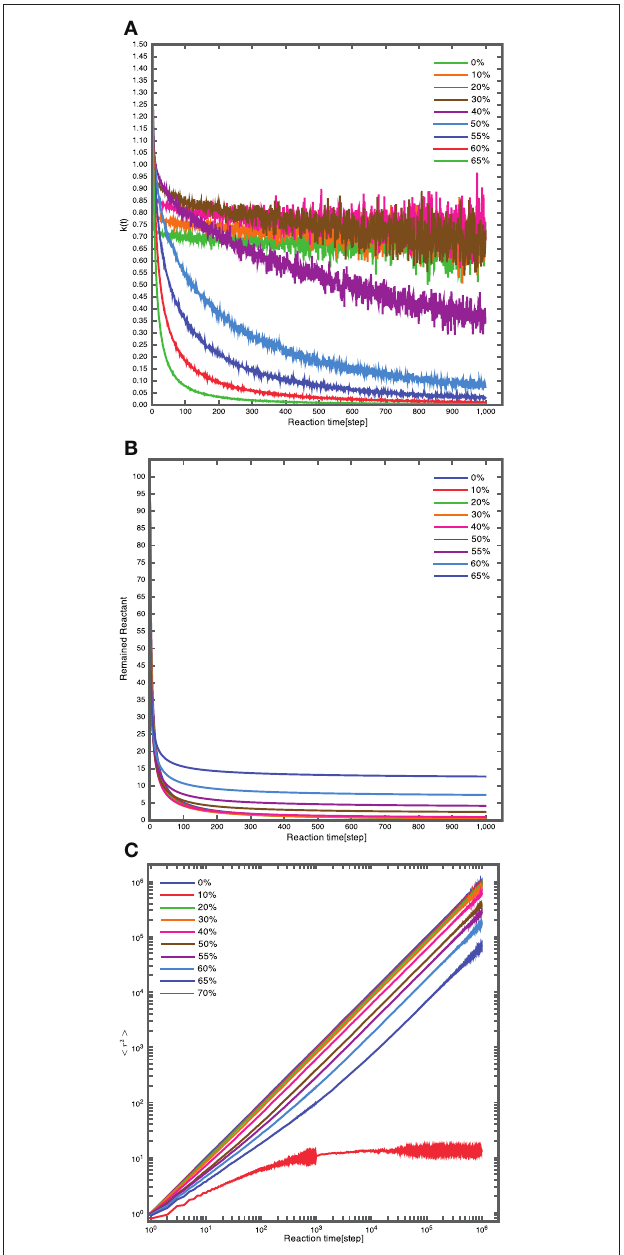
Table 4 | Noise effect examination at d